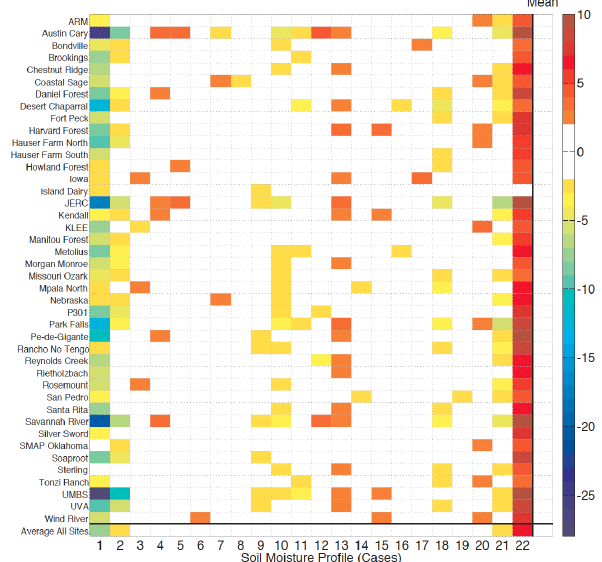
Fig. 5. Percentage difference illustrated by color (see key to the right) between the simulated neutron count given by COSMIC with optimized parameters and the neutron count given by MCNPX normalized by the MCNPX count for each of the sites shown in Fig. 3 and each of the hypothetical soil moisture profiles shown in Fig. 4. The last column (labeled Mean) shows the site-average difference, while the bottom row shows the average across all sites. For comparison, the typical observation error in a COSMOS probe is around 2%.